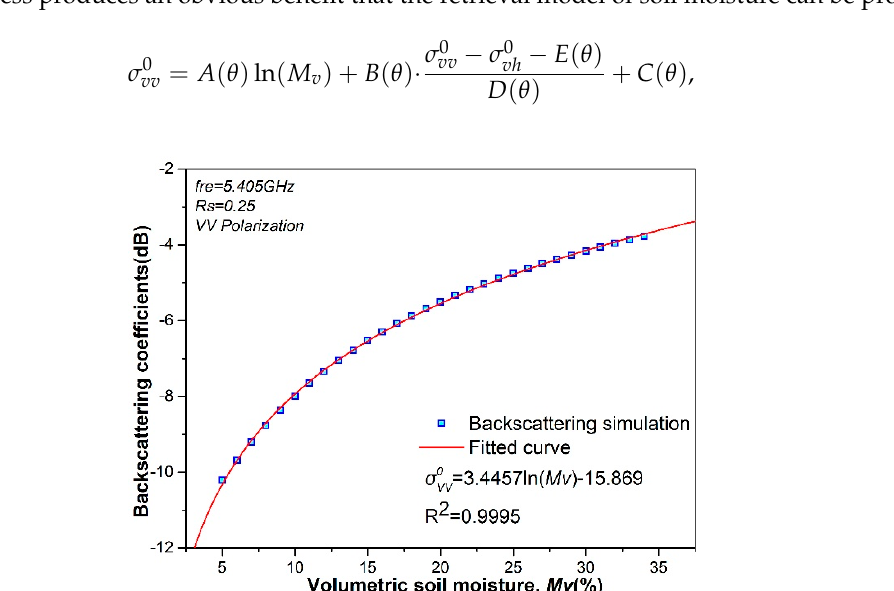
Figure 6. Backscattering coefficient (dB) simulation in the VV polarization at 30 ◦ incidence with 0.25 R s , presented using blue blocks. The red line represents the fitted curve.